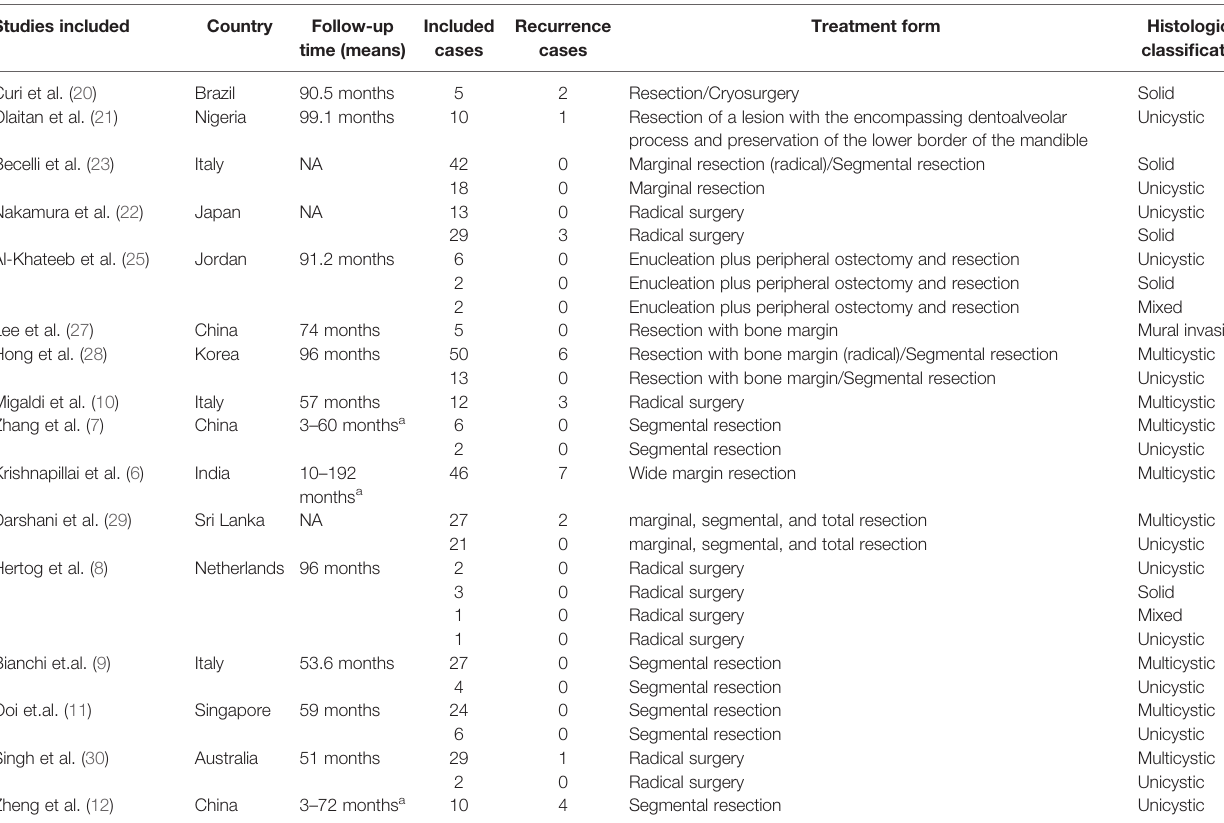
TABLE 2 | Study and participant characteristics with aggressive treatment. Studies